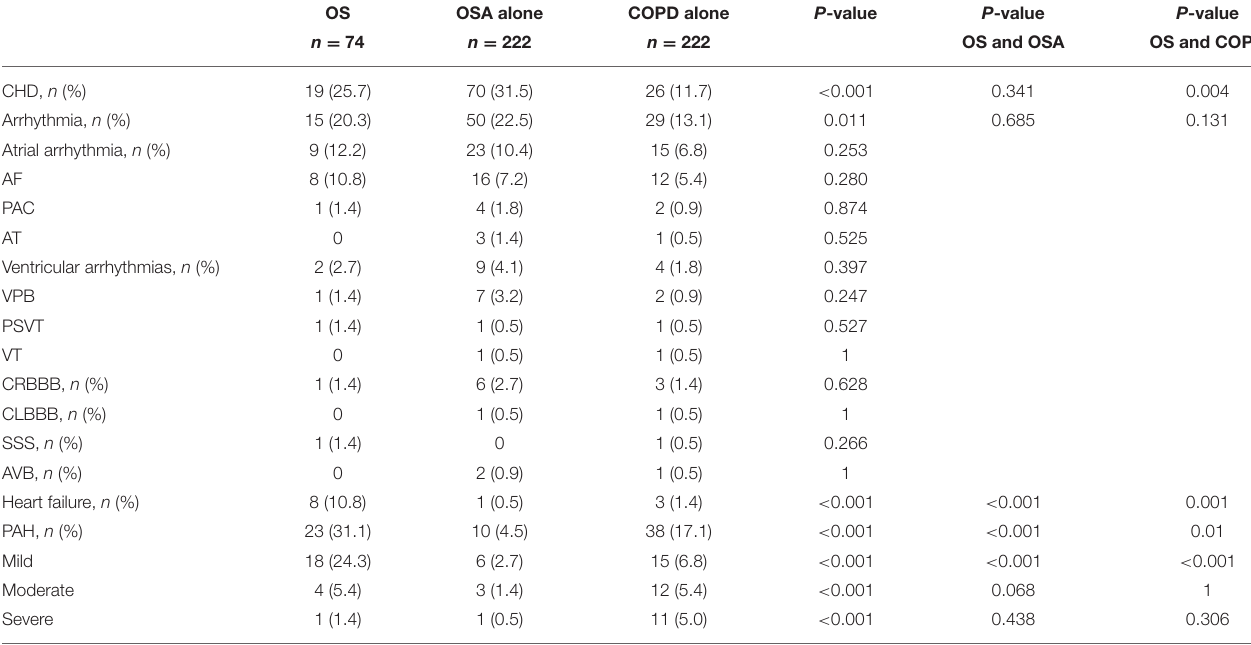
TABLE 4 | Incidence of cardiovascular events in study patients. OS OSA alone COPD alone P -value P